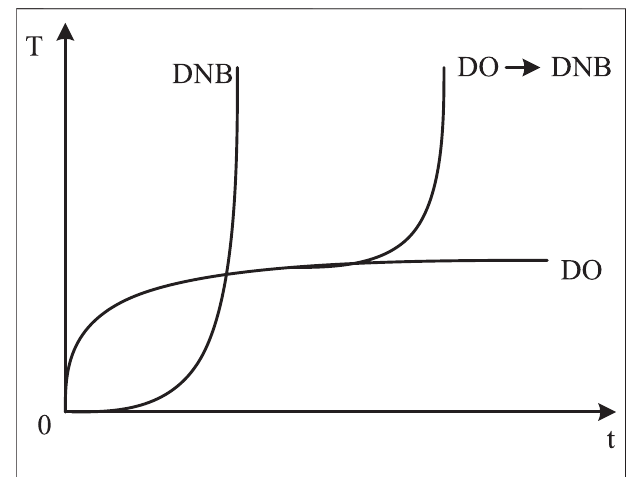
FIGURE 1 | Transition from DO to DNB regime